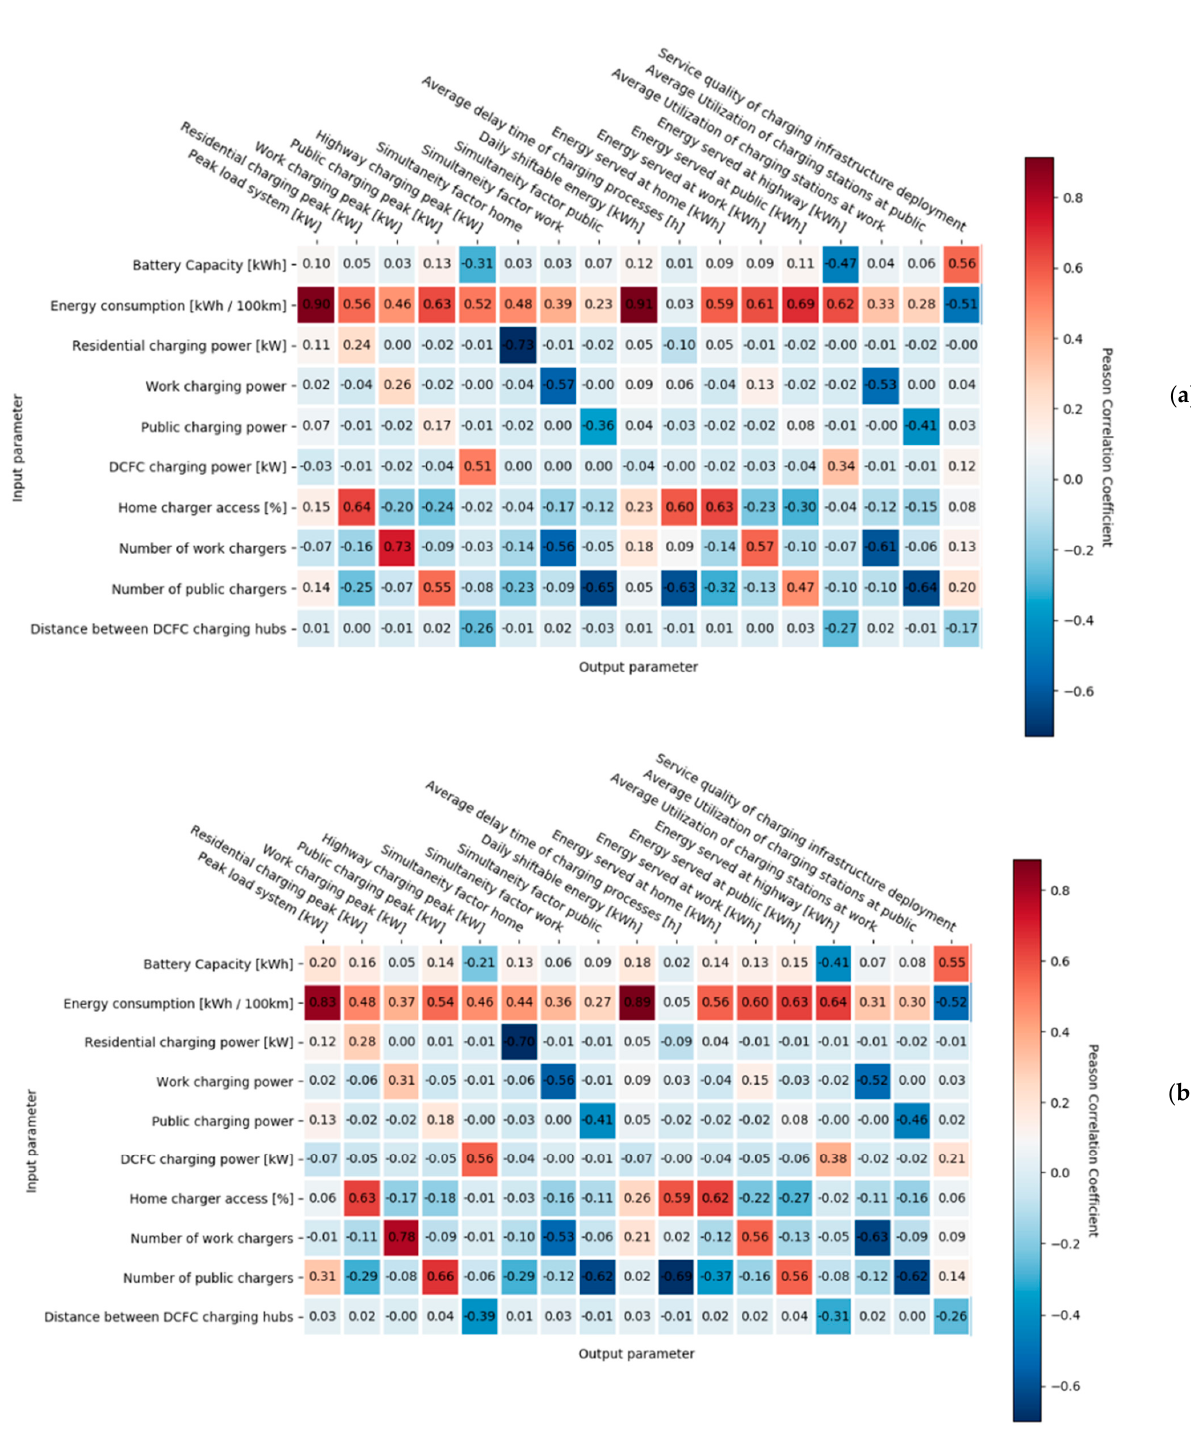
Figure A1. Sobol total order indices in dependency of the number of simulations. The number of simulations is determined by the Saltelli sampling method with N = sample size and p = number of variables.